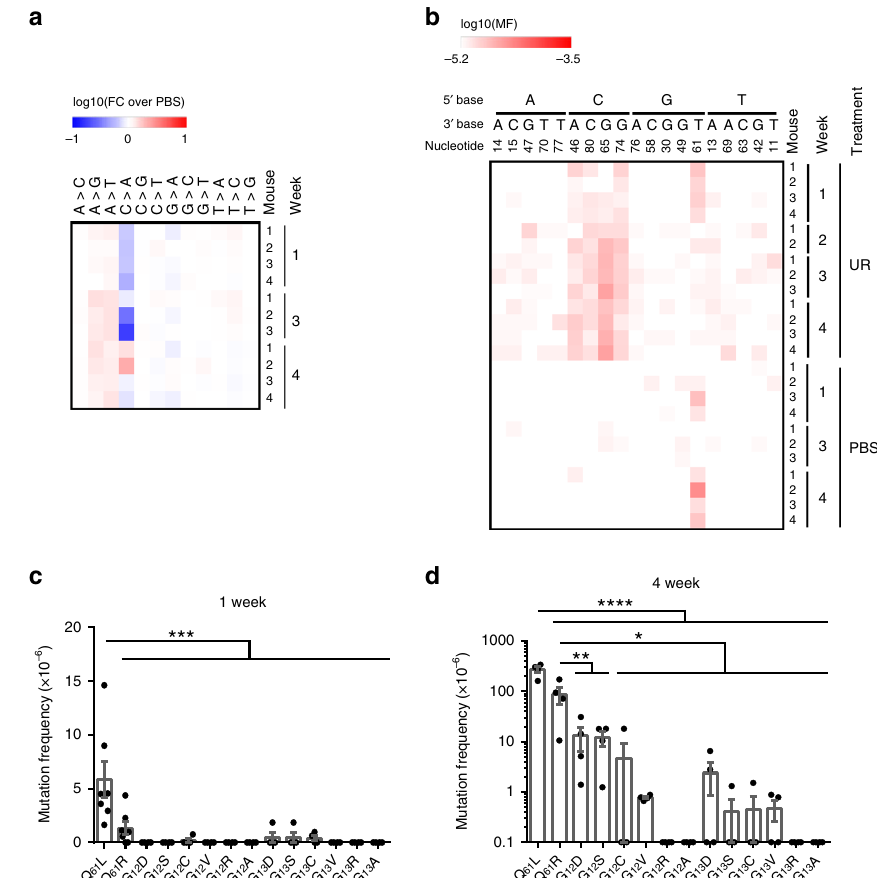
Fig. 2 MDS detects the position and substitution tropism of urethane. a , b Heatmap of the mutation frequency (MF) determined by MDS for the transcribed strand of exon 1 of Kras from the lungs of mice at the indicated time points after exposure to urethane (UR) or PBS ( n = 2 mice for the UR cohort at week 2, 3 mice for the UR and PBS cohorts at week 3, and 4 mice for all other cohorts from one experiment), plotted as the ( a ) log-transformed fold-change normalized to PBS-treated mice (FC over PBS) or ( b ) log-transformed versus each ( a ) type of substitution or ( b ) A>T transversions (nucleotide number as well as the 5 ʹ and 3 ʹ base of the substituted A are shown at the top). c , d Mean ± SEM mutation frequency for all possible oncogenic mutations at G 12 and G 13 ( n = 4 mice from one experiment) compared with the previous determined mutation frequency at codon Q 61 (Fig. 1, n = 7 mice at week 1 and 4 mice at week 4 from one experiment) ( c ) 1 week or ( d ) 4 weeks after urethane exposure. p values calculated by Holm-Sidak multiple comparisons test following one-way ANOVA. **** p < 0.0001, *** p < 0.001, ** p < 0.01, and * p <